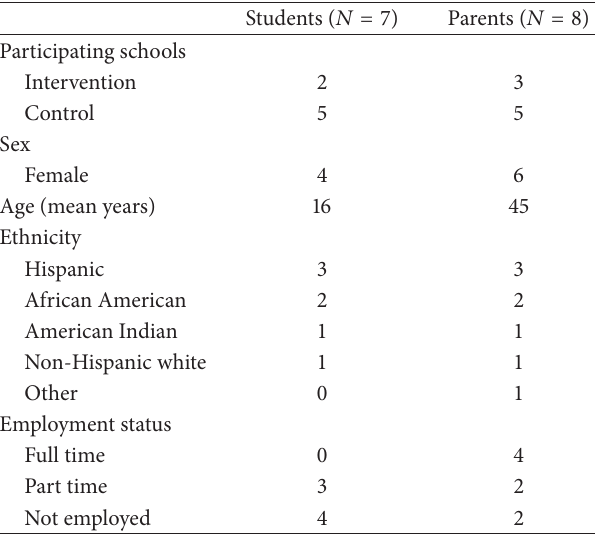
Table 2: Demographic characteristics of student and parent inter-